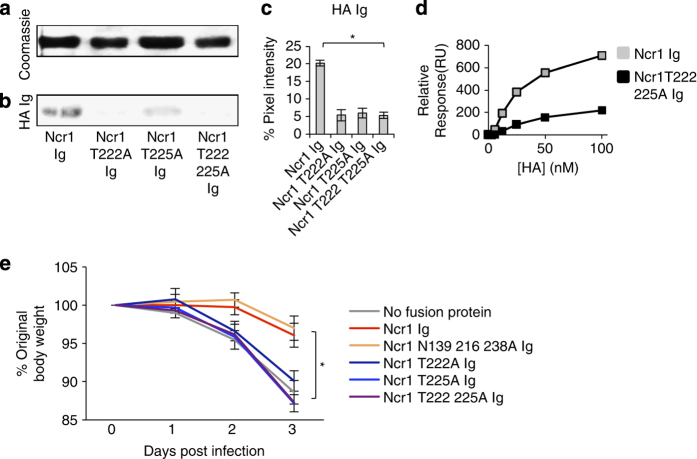
The O-linked glycosylations of Ncr1 are essential for its HA recognition and activation in vitro and in vivo.(a) Coomassie staining of the various fusion proteins (5 μg) run on 10% SDS-PAGE gel under reducing conditions. The same protein gel was used as loading control for the blotting presented in Figure 3 and here and therefore the Coomassie staining presented in a is the same as the one presented in Figure 3a and is shown here again only for better clarity. (b) Staining was performed with biotinylated HA Ig. The figures are representative of three independent experiments. Backgrounds in the Coomassie and in the WB staining were adjusted for better clarity. (c) Ratio between the Coomassie staining and the HA Ig staining (quantified by pixel intensity) in three independent experiments. Values are shown as mean±s.e.m. *P<0.05. (d) Surface plasmon resonance plots of the Ncr1 fusion proteins binding to HA. (e) Ratio between the original body weight before infection (day 0) and on 3 consecutive days following infection with influenza virus PR8, untreated or treated with the various fusion proteins. The experiment was repeated twice and at least eight mice were used in each group in each experiment. The figure represents data from the two experiments combined. Values are shown as mean±s.e.m. *P<0.05.